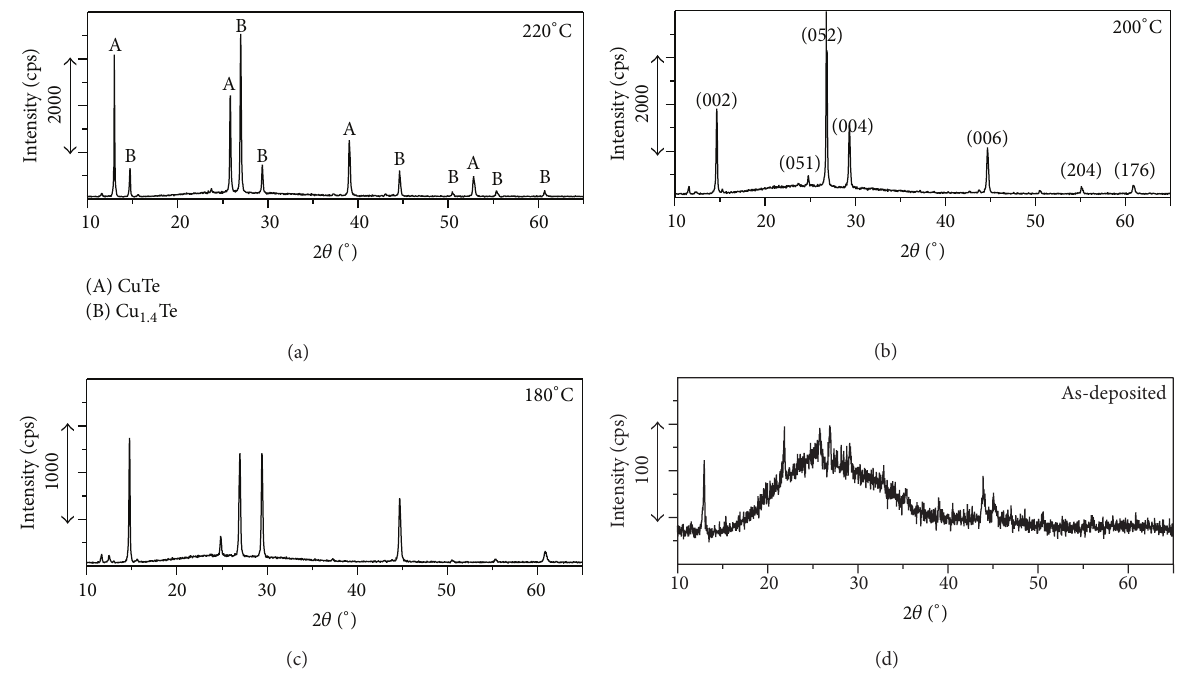
Figure 2: XRD patterns of copper telluride thin films as deposited and annealed at different temperatures.